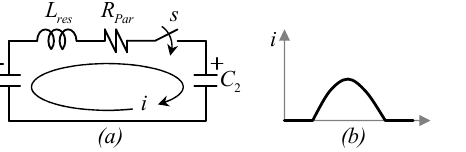
Figure 19. Basic resonant SC circuit, ( a ) schematic, ( b ) current between capacitors with resonant charge interchange.